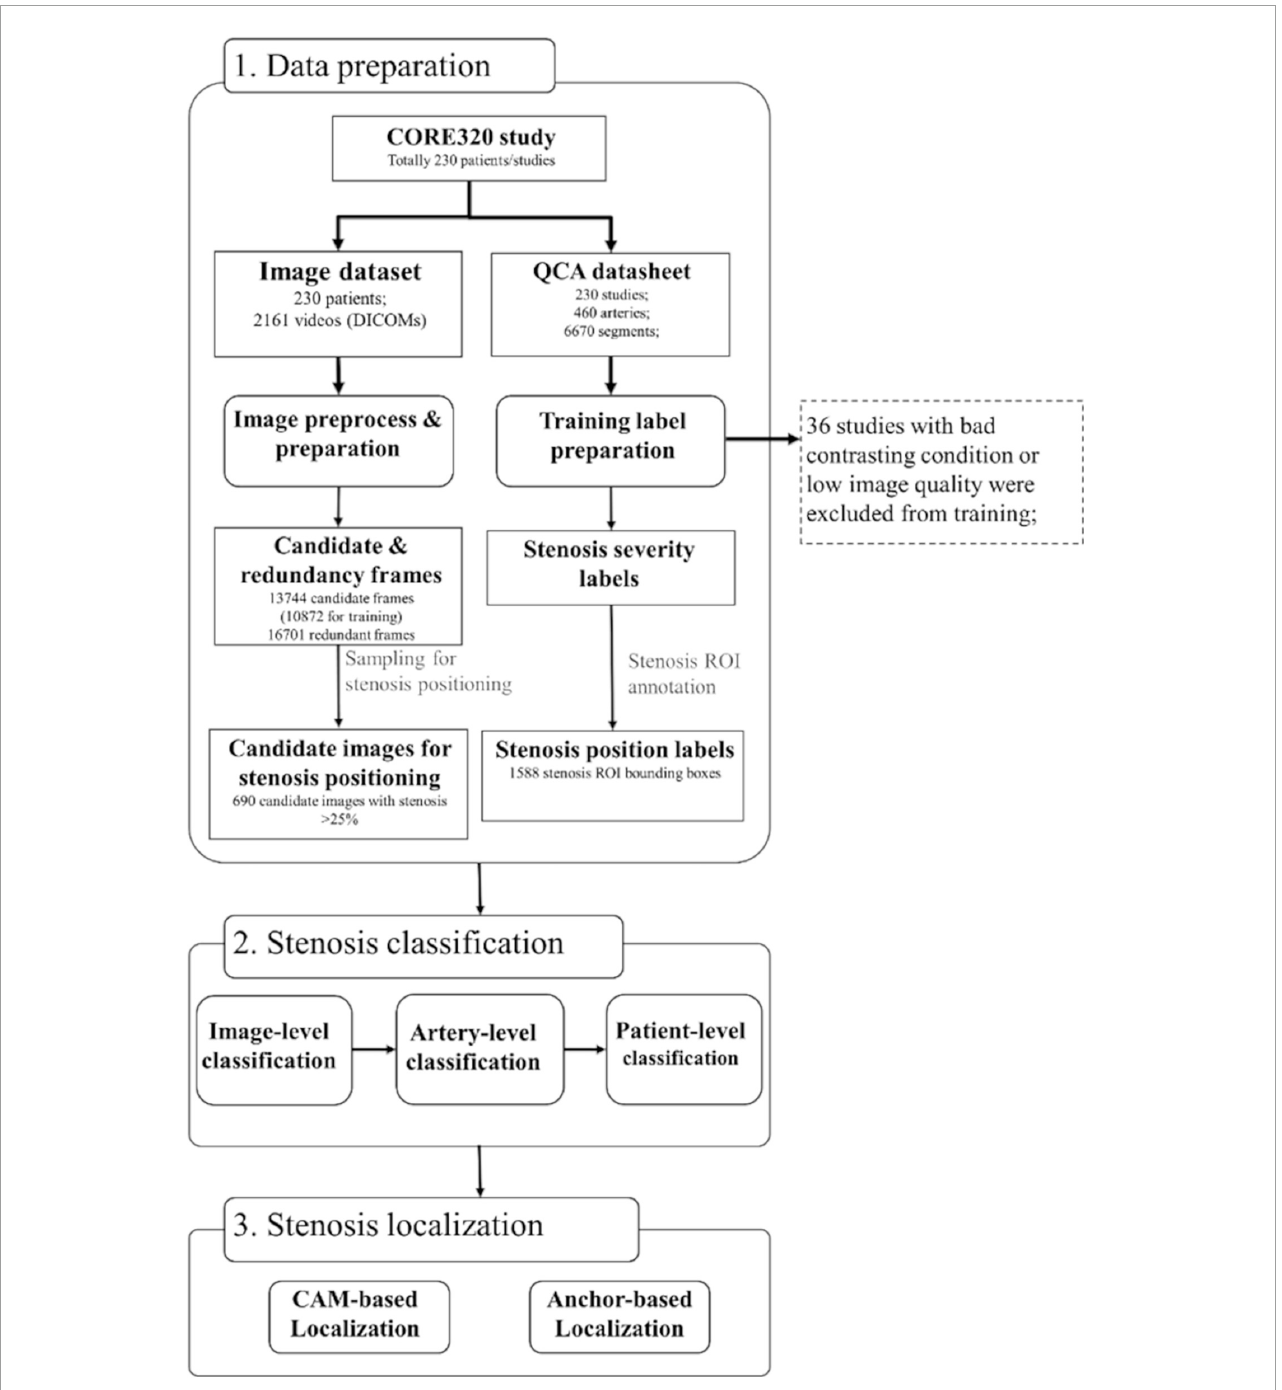
FIGURE1 Dataset and algorithm workflow. Three steps of data preparation, stenosis classification, and stenosis positioning were presented. The steps of image and training label preparation including coronary artery selection, viewing angle selection, and contrasting frame detection were designed in a fully automatic manner. Stenosis severity classification training was performed on image-level, artery-level, and patient-level. Stenosis positioning was performed in two methods of CAM-based and anchor-based methods. CAM, class activation map; QCA, quantitative coronary